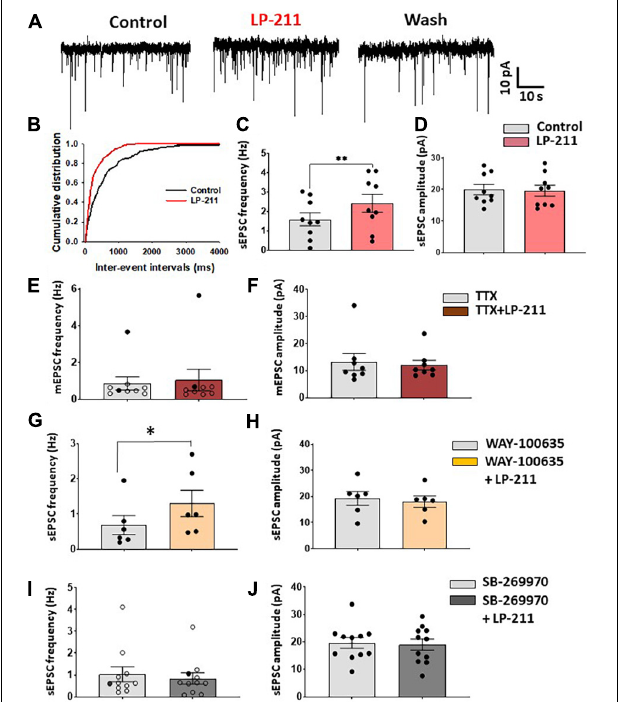
FIGURE 1 | Application of LP 211 increases spontaneous EPSCs in a subpopulation of lamina II neurons. (A) Examples of spontaneous EPSC recordings (sEPSCs), obtained in voltage-clamp at –70 mV. LP-211 (1 µ M) caused a significant increase in sEPSC frequency, which was reversible in the wash. (B) Cumulative distributions of the inter-event intervals determined from the neuron shown in panel (A) . LP-211 caused a shift of the curve to the left, indicating an increase in sEPSC frequency (Kolmogorov–Smirnov test, p = 0.000). (C) Summary graph of sEPSC frequencies obtained from the neurons responsive to LP-211 (9 out 14 tested cells; paired t -test, p < 0.01); (D) LP-211 did not change sEPSC amplitude in the responsive cells (paired t -test, p = 0.69, n = 9). (E) Tetrodotoxin (TTX, 1 µ M) reduced the effect of LP-211 on spontaneous glutamate release: in only 2 neurons (black circles) out of 9 a significant increase of mEPSC frequency was observed. The overall effect of LP-211 on mEPSC frequency was not significant (Wilcoxon rank-sum test, p = 0.91). (F) No changes in mEPSC amplitude were observed in LP-211 + TTX (Wilcoxon rank-sum test, p = 0.96, n = 9). (G,H) Co-application of the 5-HT 1 A antagonist WAY 100-635 (10 µ M) did not prevent the increase of sEPSC on 6 out of 10 tested neurons (paired t -test on responsive cells, p < 0.05, n = 6). The sEPSC amplitude was not significantly changed (paired t -test, p = 0.39, n = 6). (I) Co-application of LP-211 with the 5-HT 7 antagonist SB-269970 (10 µ M) blocked both the LP-211 effects on sEPSC frequency [ (I) : only one responsive cell (black circles) out of 11 tested, Wilcoxon rank-sum test, p = 0.17, n = 11] and amplitude [ (J) : paired t -test, p = 0.4, n = 11]. Asterisks reported in the graphs represent statistical